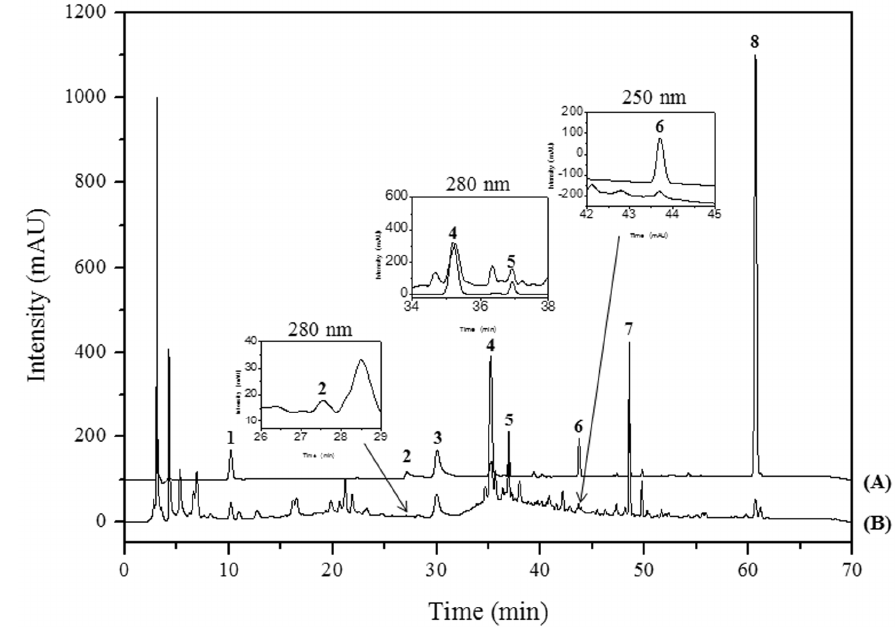
Figure 5. HPLC chromatograms of (A) a standard mixture and (B) PM at 250 nm.